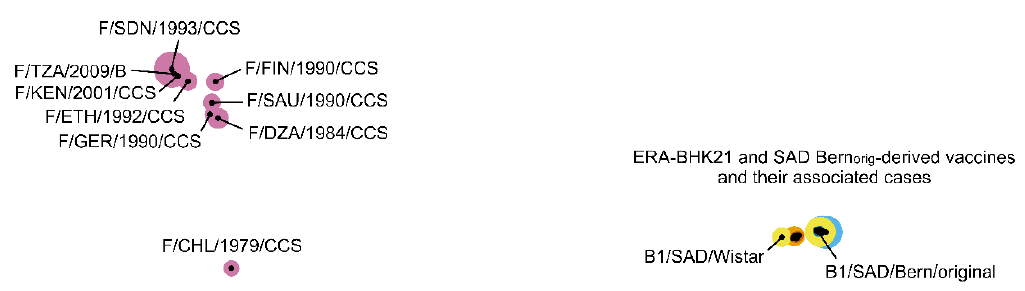
Figure 3. Population-based analysis of ERA-BHK21- and SAD-Bern orig -derived vaccine strains and viruses of their vaccine-induced rabies cases in relation to selected field RABV strains (F/…).